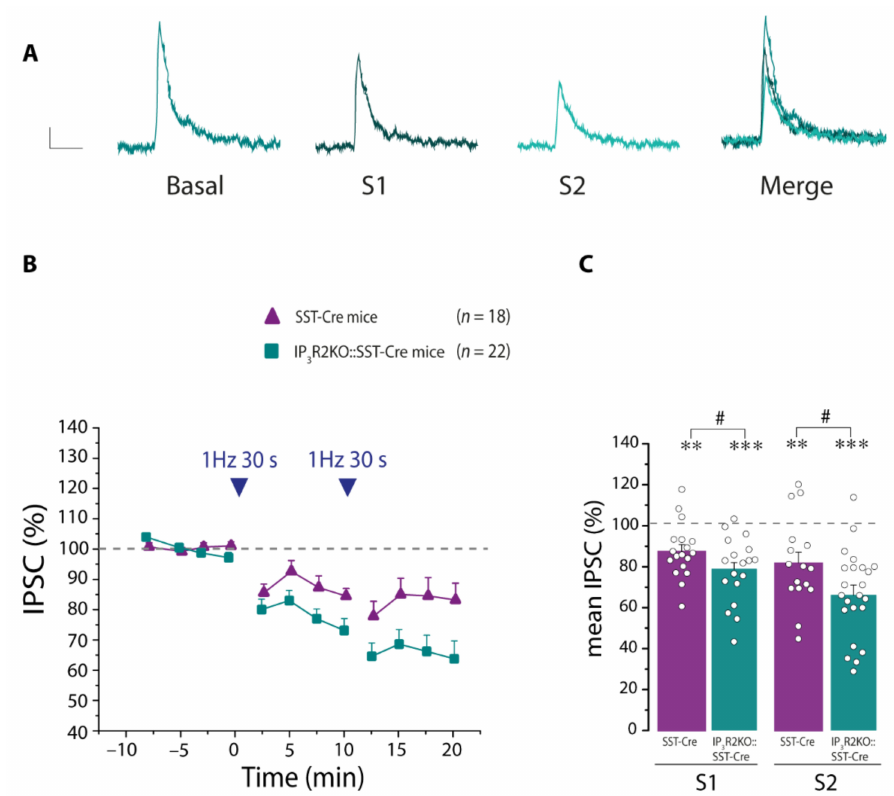
Figure 9. IP 3 R2-mediated signaling pathway counterbalances disinhibition of PNs. ( A ) Represen- tative IPSCs before (basal) and after the first (S1) and the second (S2) 30 light pulses and merger of all IPSCs, in an IP 3 R2KO::SST-Cre mouse. Scale bar, 50 ms, 10 pA. ( B ) Mean normalized IPSCs amplitude before and after the 30 light pulse stimulation in the IP 3 R2KO::SST-Cre mice ( n = 22). ( C ) Quantification of the mean normalized IPSC amplitude during the 10 min after the first (S1) and second (S2) stimulation in the IP 3 R2KO::SST-Cre mice. Note that in IP 3 R2KO::SST-Cre mice the disinhibition of PNs is stronger compared to that observed in SST-Cre mice. * statistical comparison with basal conditions, ** p < 0.01, *** p < 0.001, paired t -test. # statistical comparison with values in SST-Cre mice, # p < 0.05, unpaired t -test.